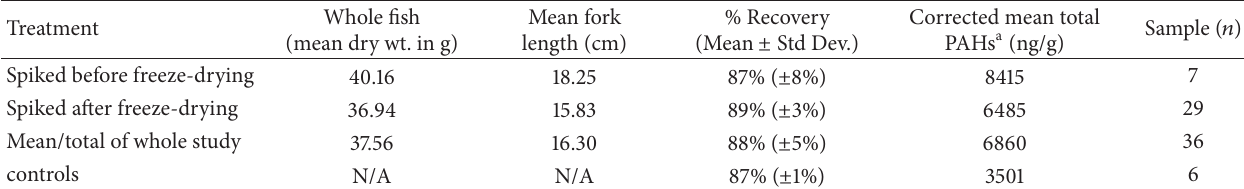
recovery using a modified MSPD protocol. 10